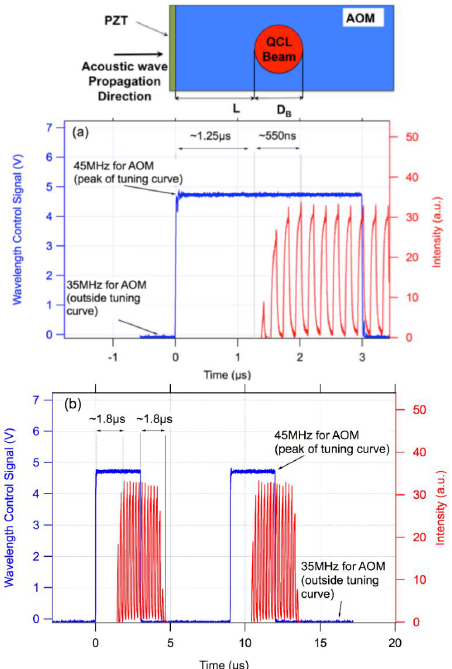
Figure 2. Switching time data for the AOM-controlled EC QCL setup. ( a ) AOM frequency switches from 35 MHz outside the tuning curve to 45 MHz corresponding to the center of the tuning curve.